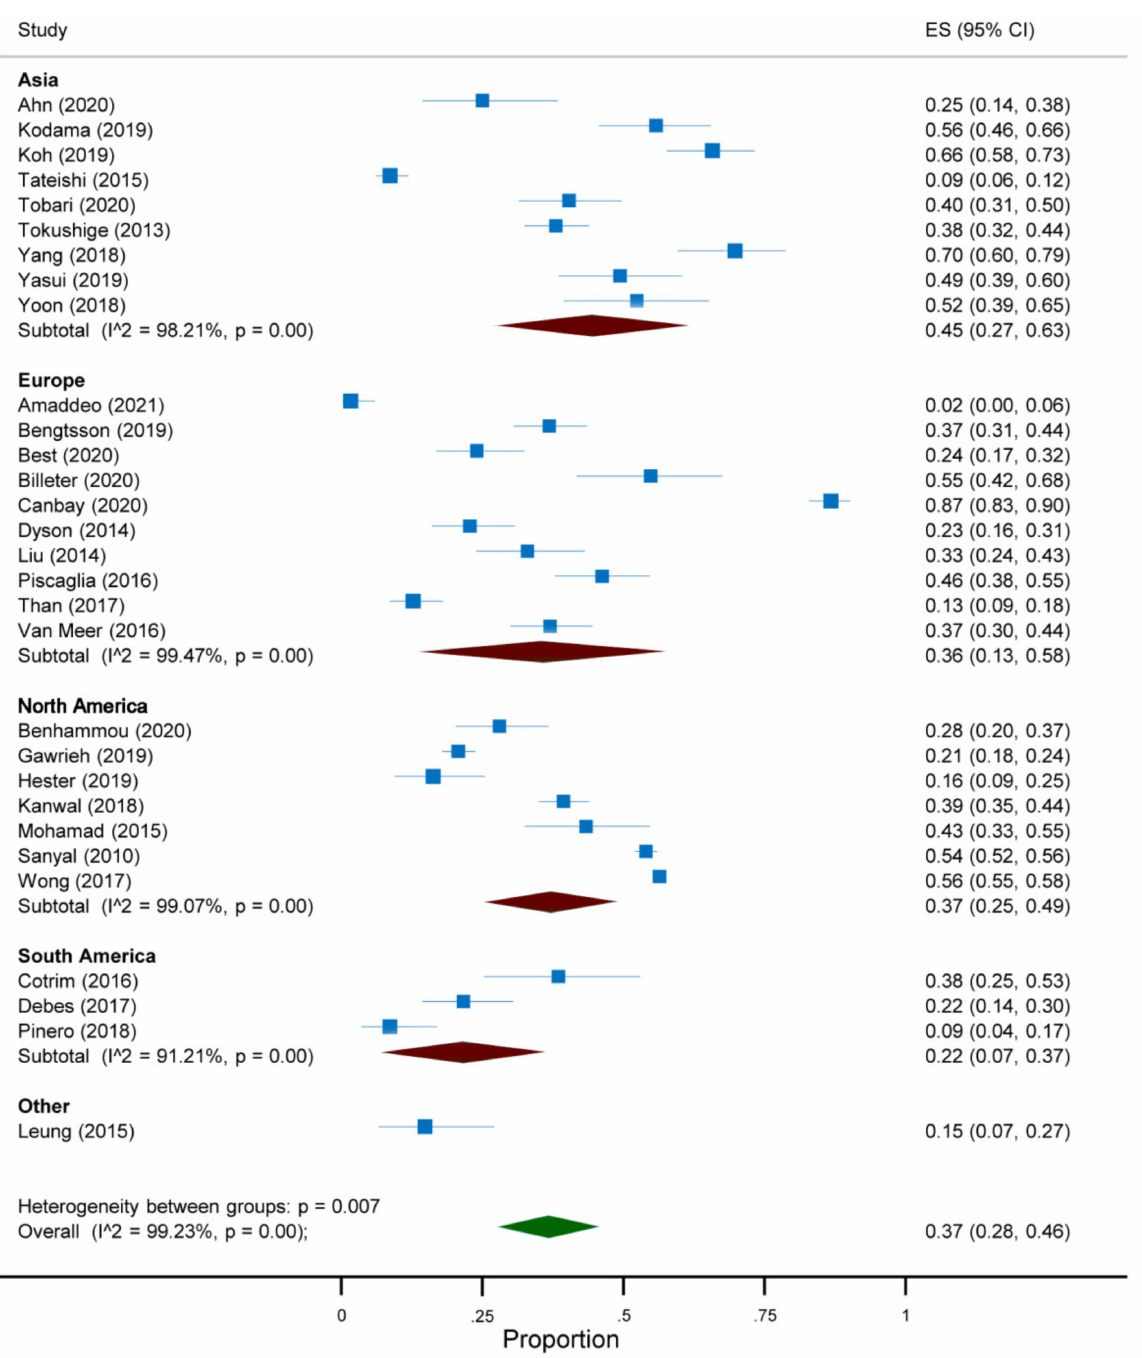
Figure 3. Forest plot of the absence of cirrhosis in subjects with NAFLD-associated HCC according to the